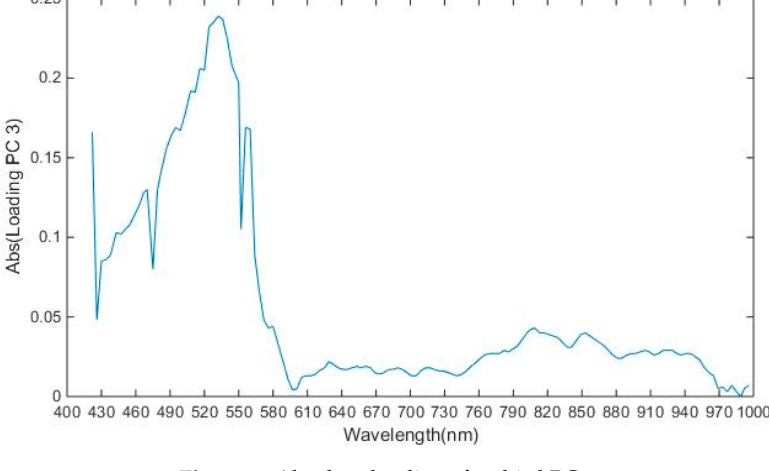
Figure 8. Absolute loadings for third PCs.